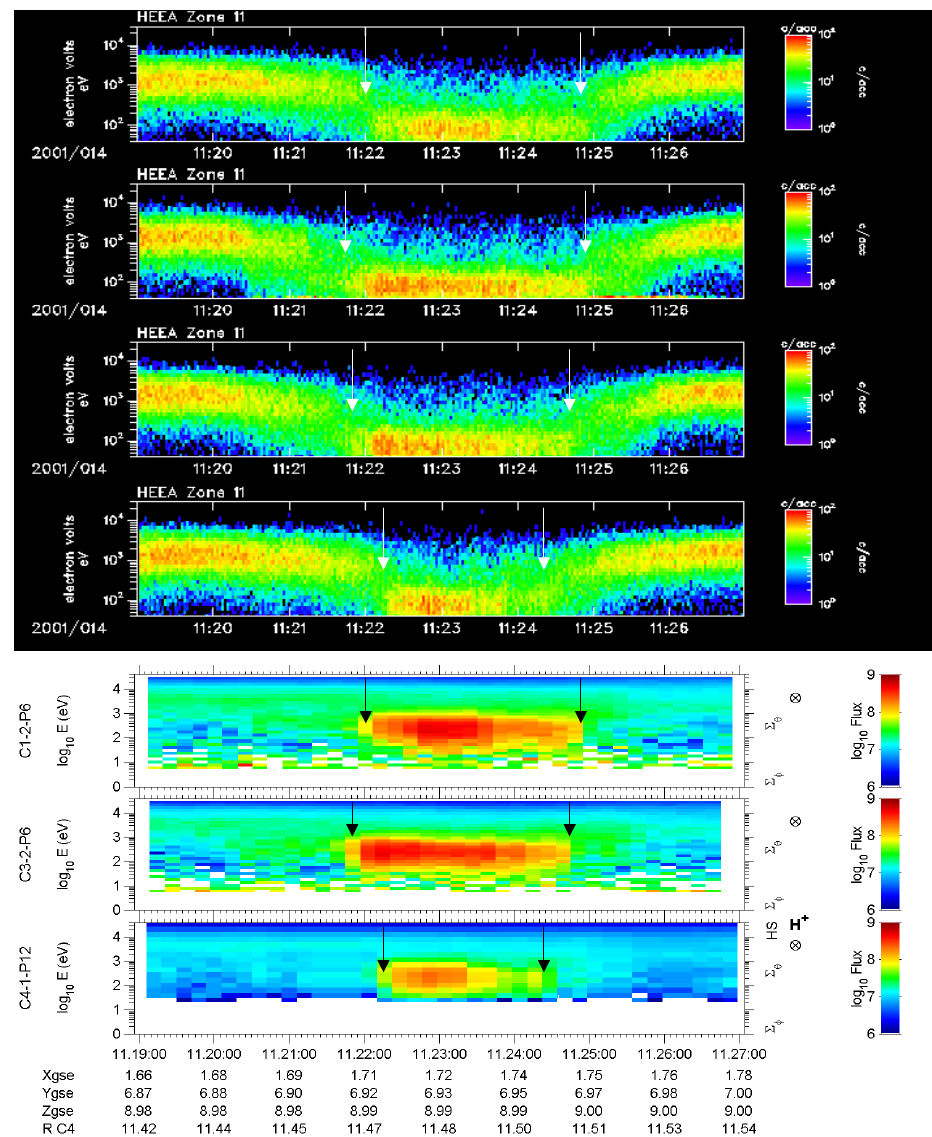
Fig. 8. Observations of the electrons and ions made by the PEACE and CIS instruments of the Cluster spacecraft at 11:19–11:27. (a)–(d) are energy-time spectrograms of count rates seen by the HEEA detector of PEACE in zone 11 (electrons moving in the + Z GSE direction) for spacecraft C1, C2, C3 and C4, respectively. (e)–(g) are energy-time spectrograms of differential number flux observed by CIS for spacecraft C1, C3 and C4. The arrows mark the boundaries of the LLBL event, defined from the lowest energy sheath electrons, and plotted for the same times on the ion spectrograms and in Fig. 10.